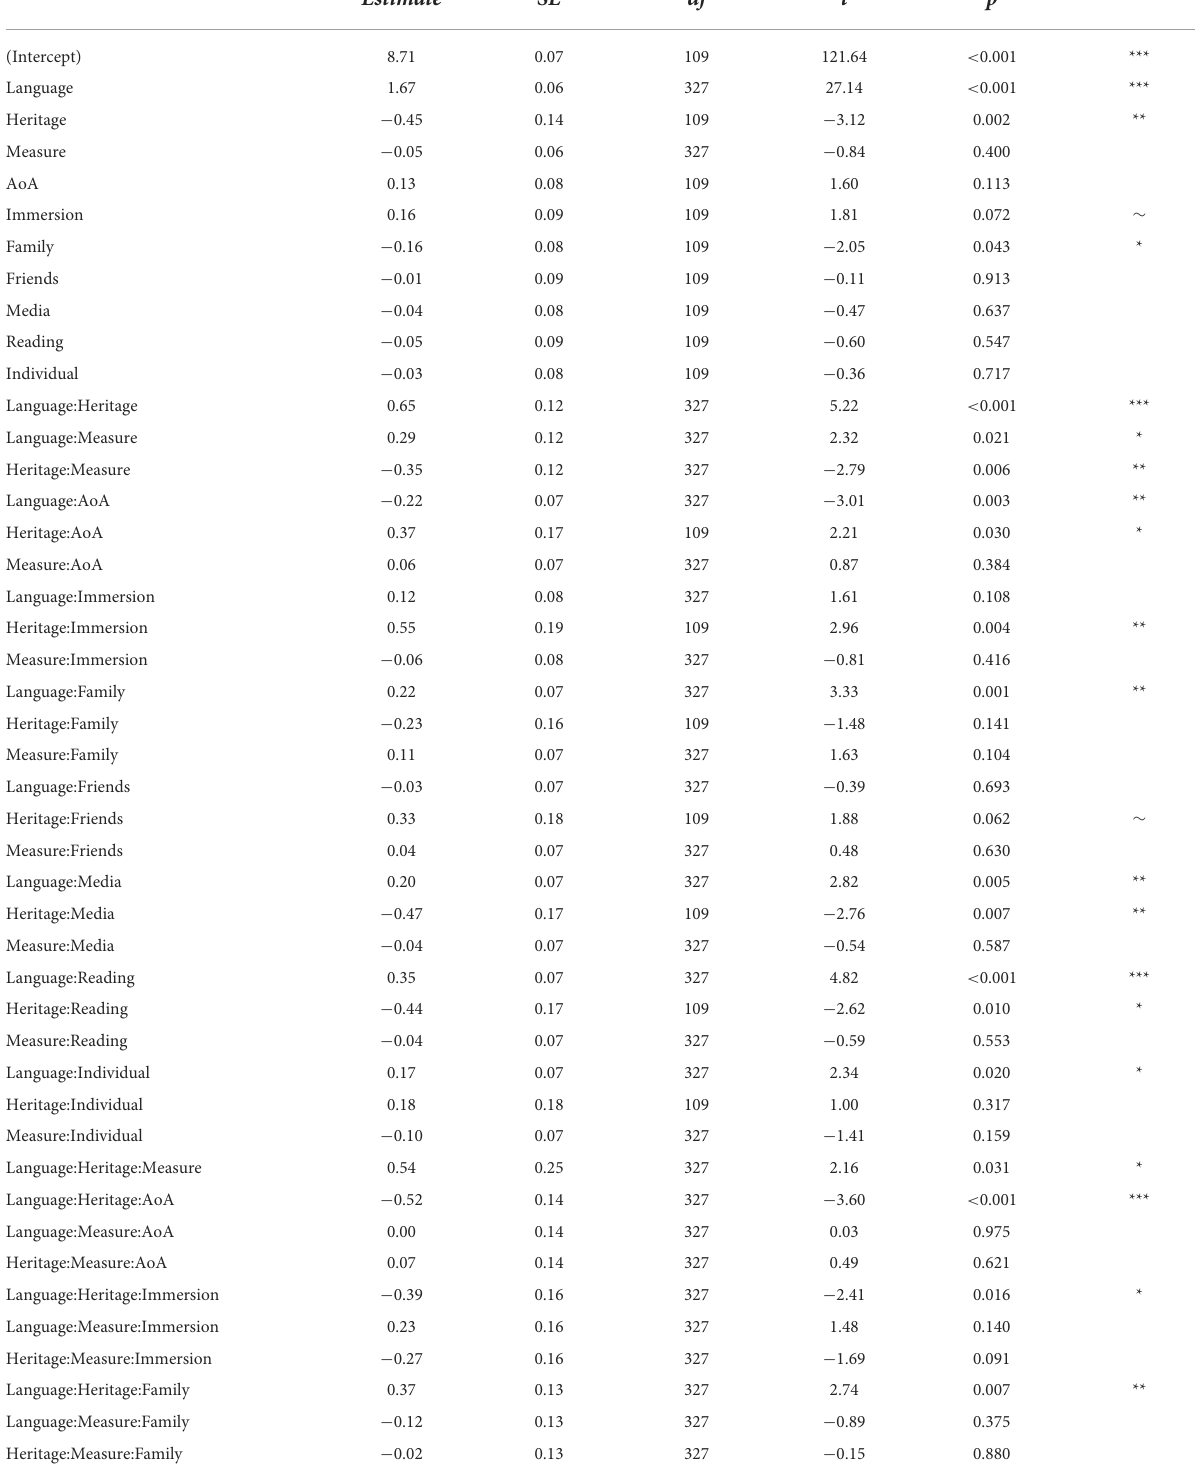
TABLE 4 Effects of relative language experience (English—HL) on self-reported heritage language and English proficiency. Estimate SE df t